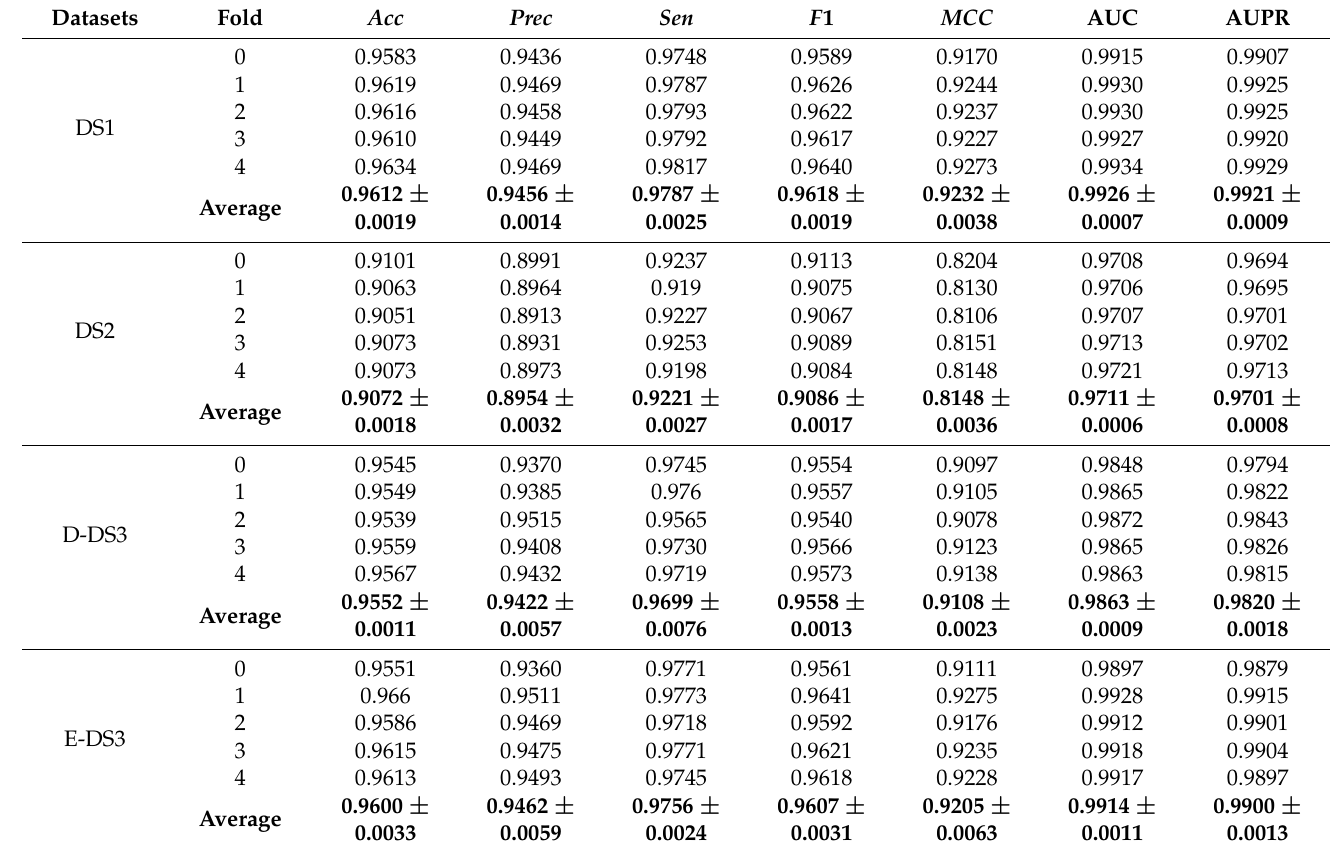
Table 2. Five-fold cross-validation results through